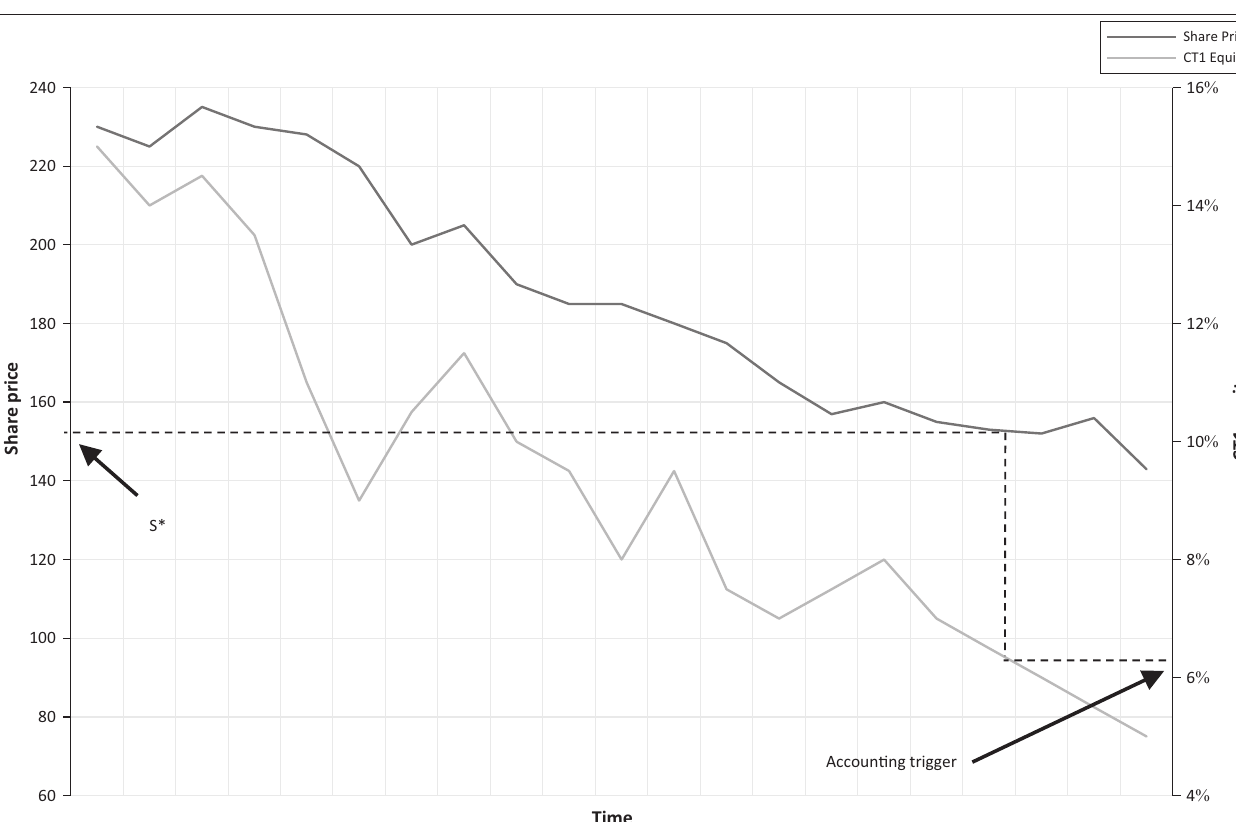
FIGURE 6: Accounting trigger with the projected market trigger S